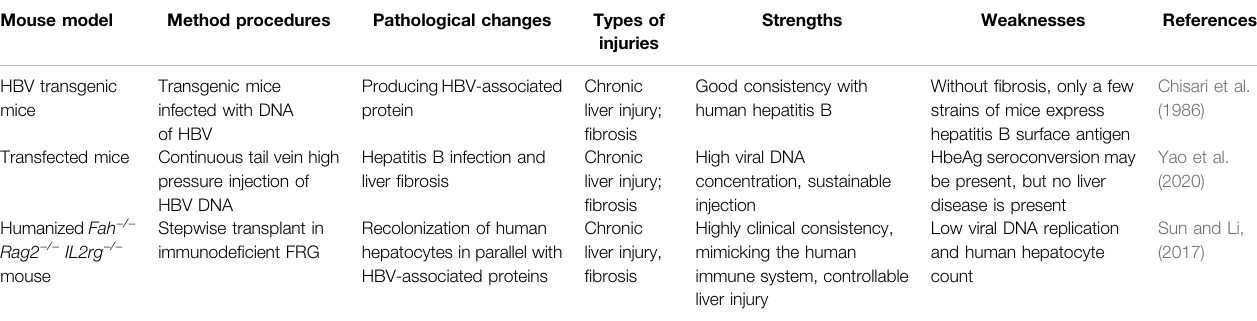
TABLE 4 | Mouse models of infectious liver